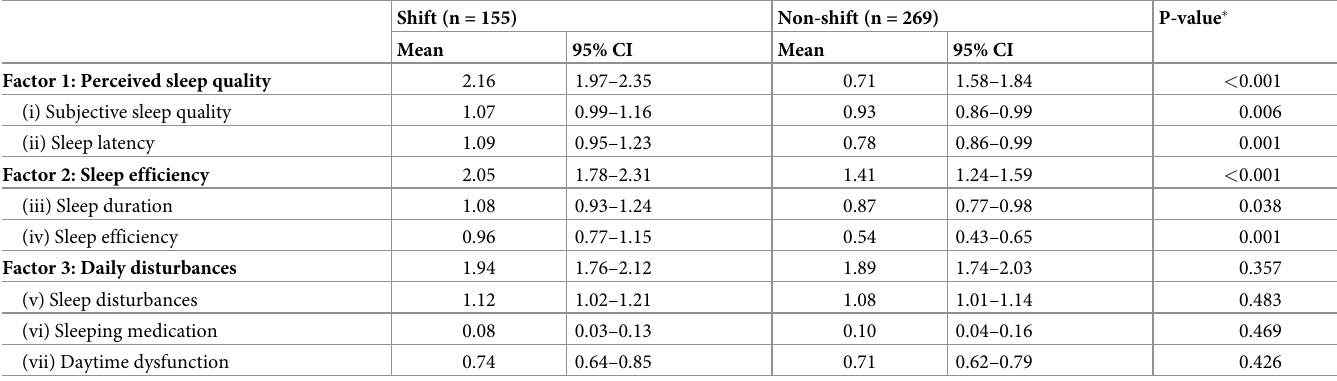
Table 3. Comparison of PSQI subscales and factors between shift and non-shift